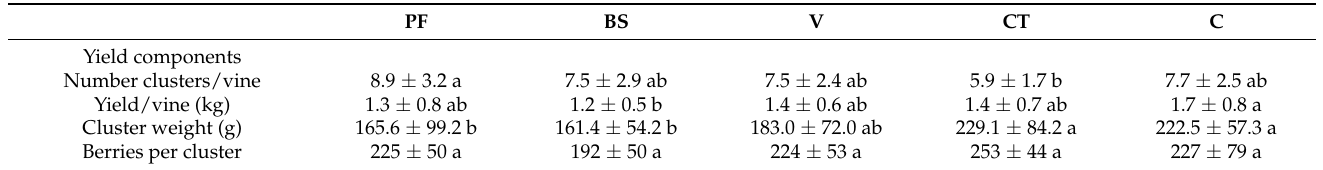
Table 1. Yield components and basic physiochemical composition of Maraština musts and wines subjected to defoliation and cluster-thinning